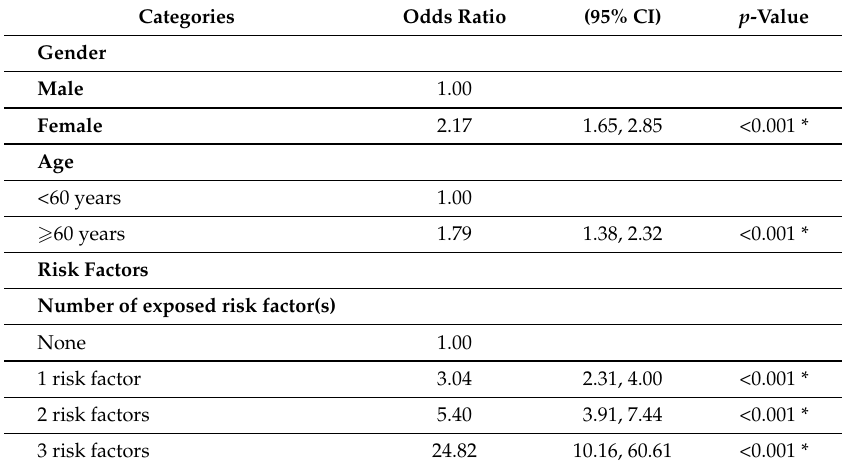
Table 2. Odds ratios of personal data and number of risk factors with OPMDs